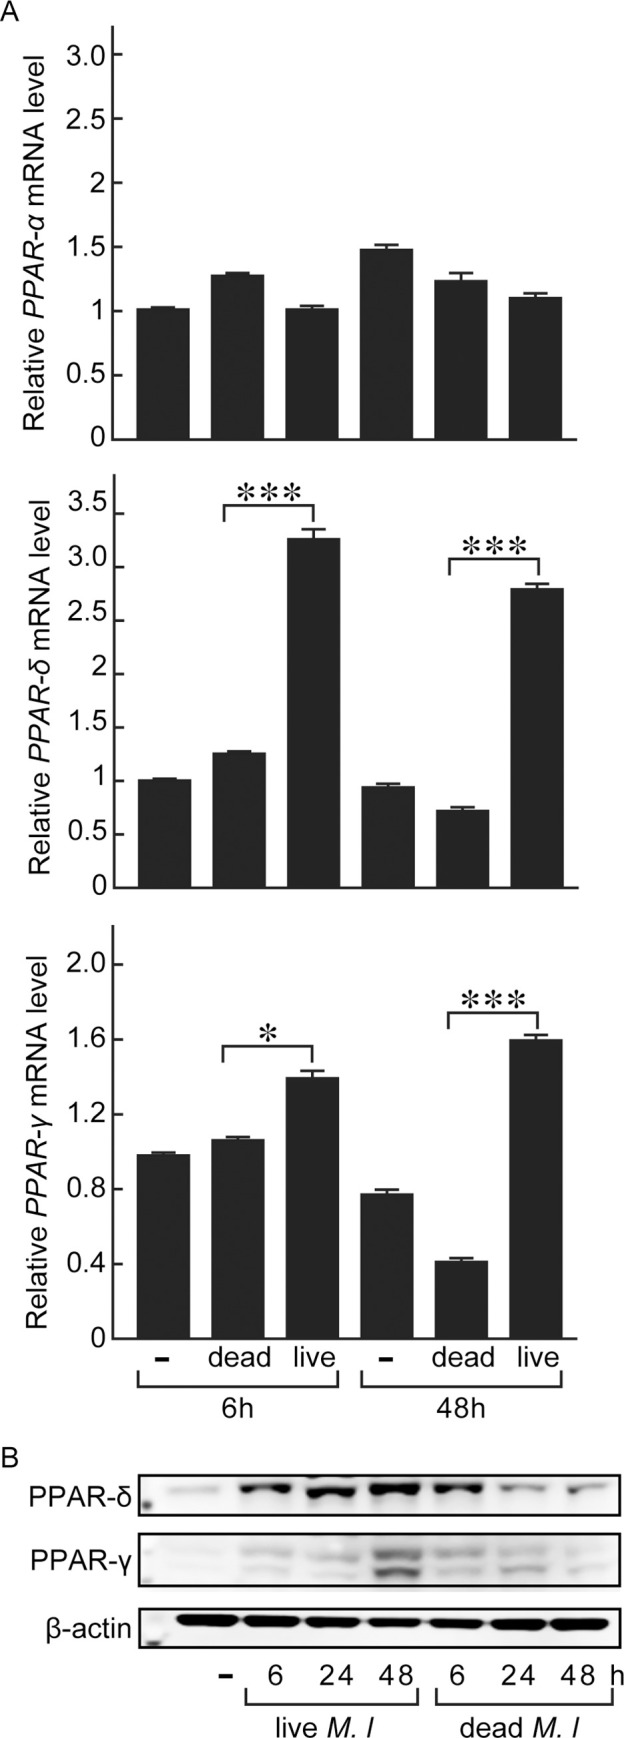
PPAR-δ and PPAR-γ mRNA and protein expressions were significantly induced in M. leprae-infected foam cells.THP-1 cells were infected with M. leprae (MOI = 100) or stimulated with heat-killed M. leprae. Cellular mRNAs and proteins were extracted at 0, 6, and 48 h after infection/stimulation. (A) PPAR-α, PPAR-δ, and PPAR-γ mRNA levels were evaluated by real-time PCR. Data are presented as mean ± SD relative to the control cells (n = 3). *P < 0.05; ***P < 0.001, compared to dead M. leprae-stimulated cells. (B) PPAR-δ and PPAR-γ protein levels were evaluated by Western blotting.